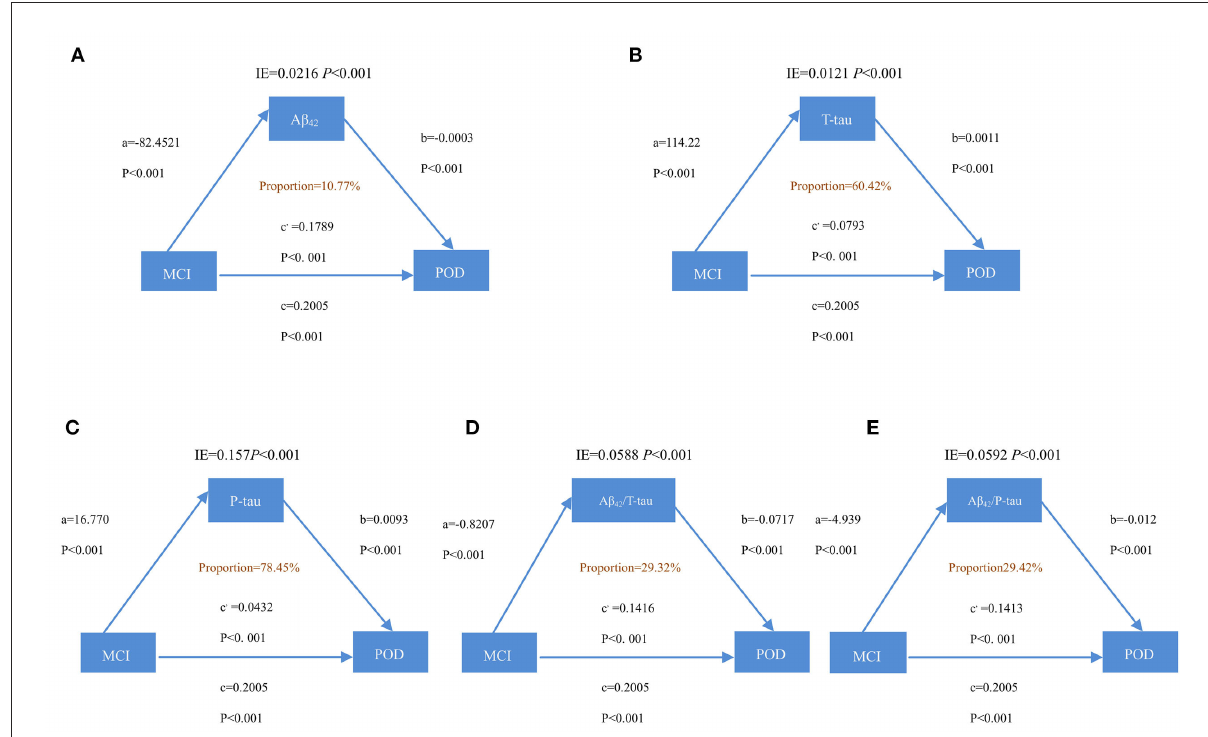
FIGURE3 Mediation analyses with POD as a cognitive outcome. In the PNDABLE (Perioperative Neurocognitive Disorder and Biomarker LifestylE study), the relationship between MCI and POD was mediated by amyloid pathology indicated by (A) amyloid β 42 (A β 42 ), (B) Total-tau (T-tau), (C) phosphorylated total-tau (P-tau), (D) amyloid β 42/ Total-tau (A β 42 / T-tau), and (E) amyloid β 42/phosphorylated total-tau (A β 42 / P-tau). IE, indirect